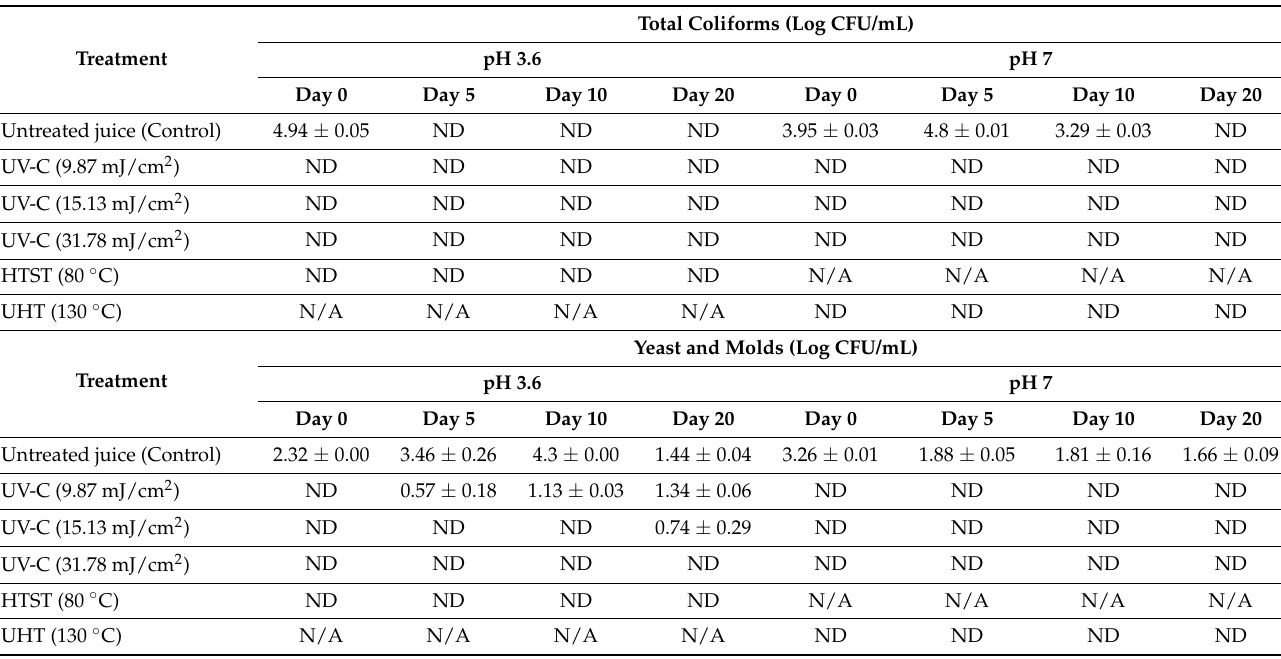
Table 2. Effect of UV-C irradiation and thermal treatment on the microbiota of red prickly pear juice.